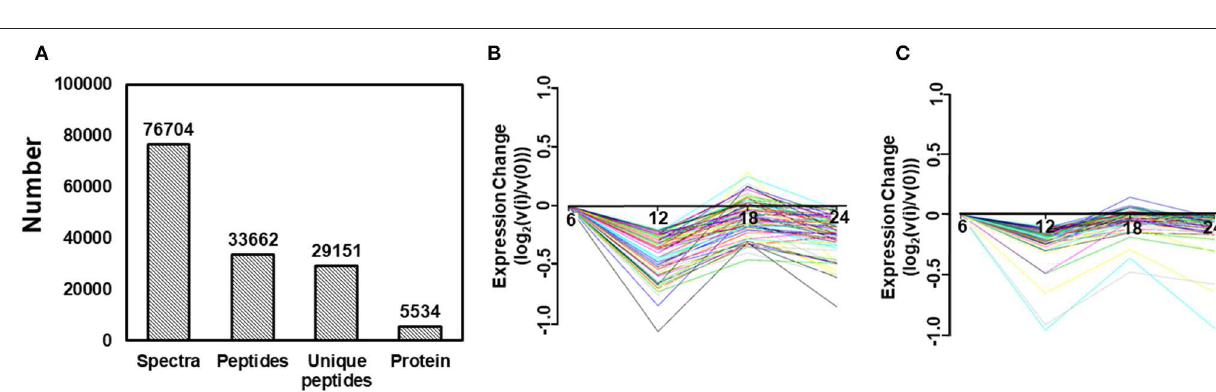
Frontiers in Microbiology |